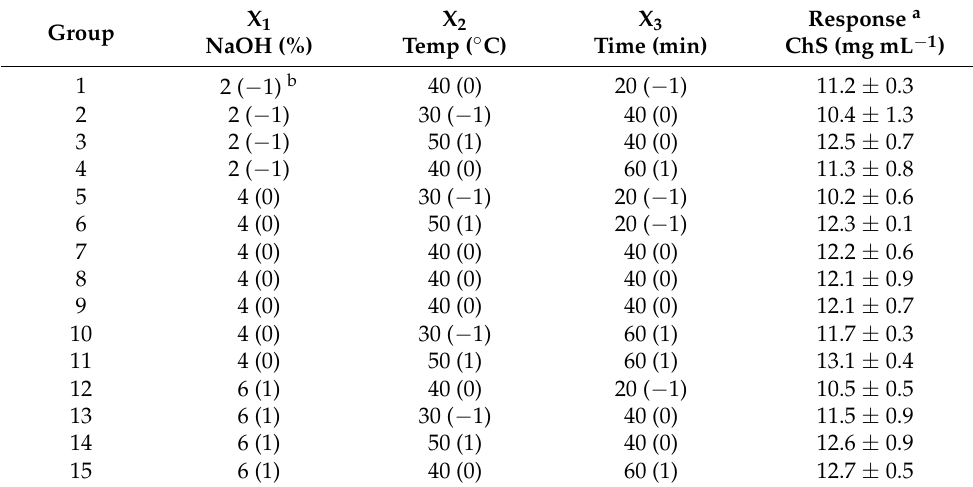
Table 2. Box–Behnken design and observed experimental data for UAE of ChS from jumbo squid